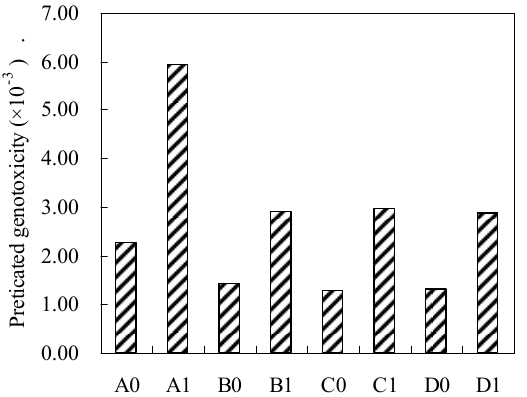
Figure 4. Estimated genotoxicity of the sum of the measured HAN and TCNM during pre-oxidation subsequent chlorination of Asp (The meaning of the number is the same as above, Asp = 0.1 mM, oxidant (OZ, PM, and Fe(VI)) = 5 mg / L, Br _ = 1 mg / L, pre-oxidant contact time = 0.5 h, chlorine contact time = 24 h, pH = 7 ± 0.2, and temperature = 22 ± 1 °C). The bars represent the standard deviation of replicate measurements ( n = 3).